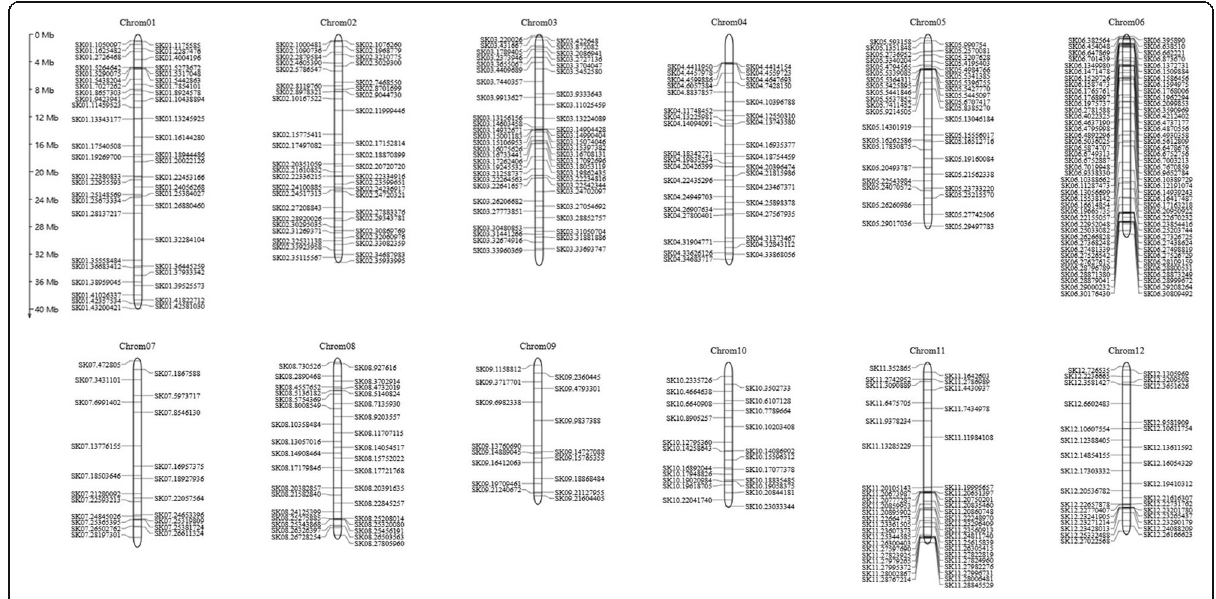
Fig. 2 Distribution of KASP-SNP markers among rice